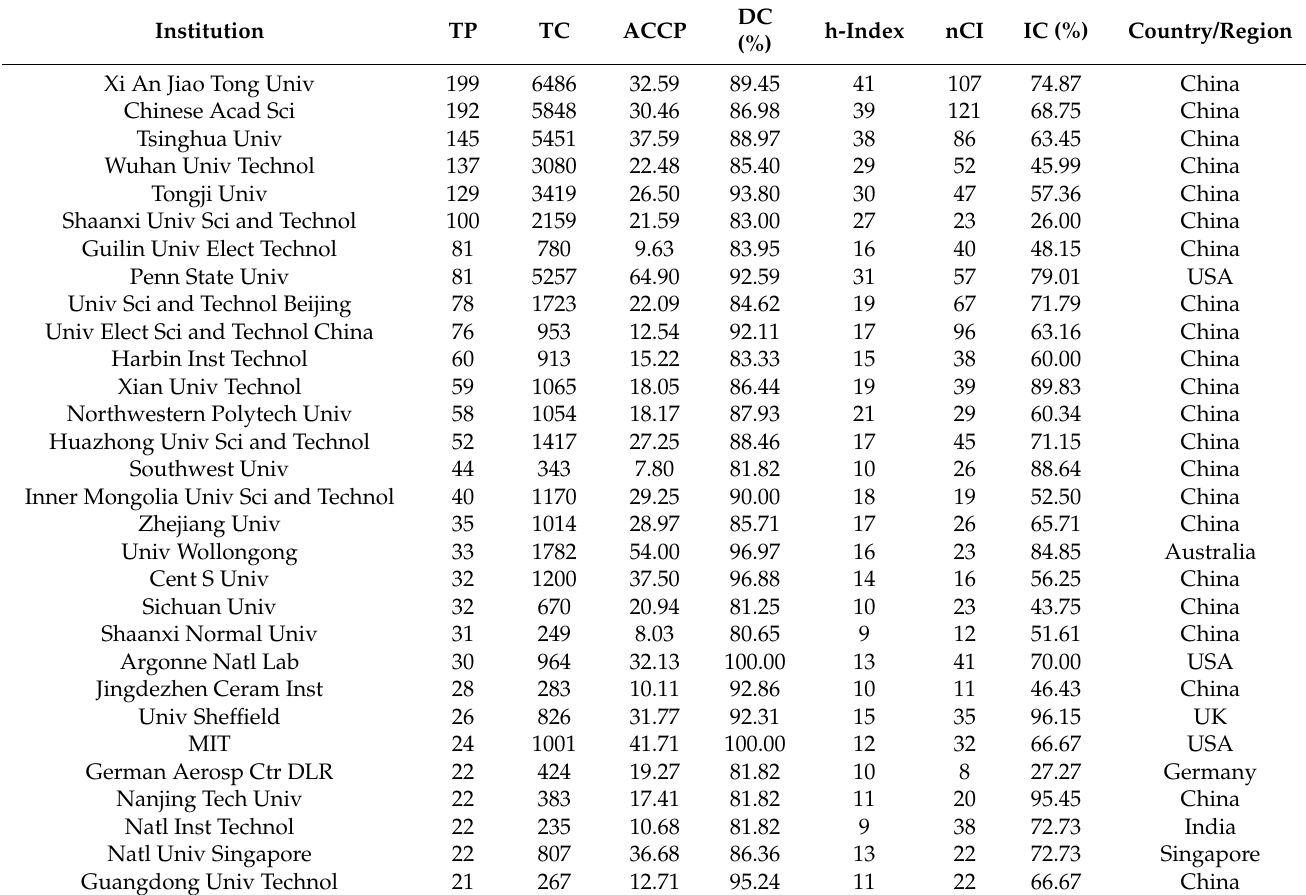
Table 2. The top 30 most productive institutions in energy storage ceramics research during the period 2000–2020. Institution TP TC